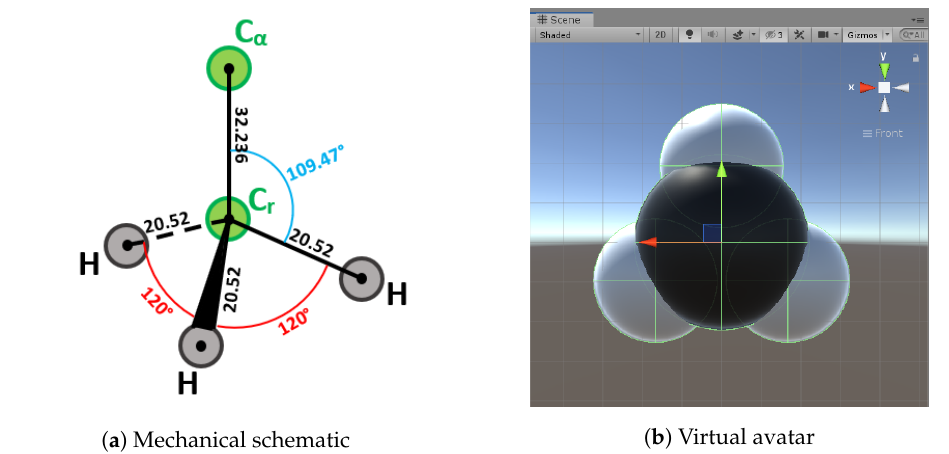
Figure 14. Physical and virtual methyl representations.